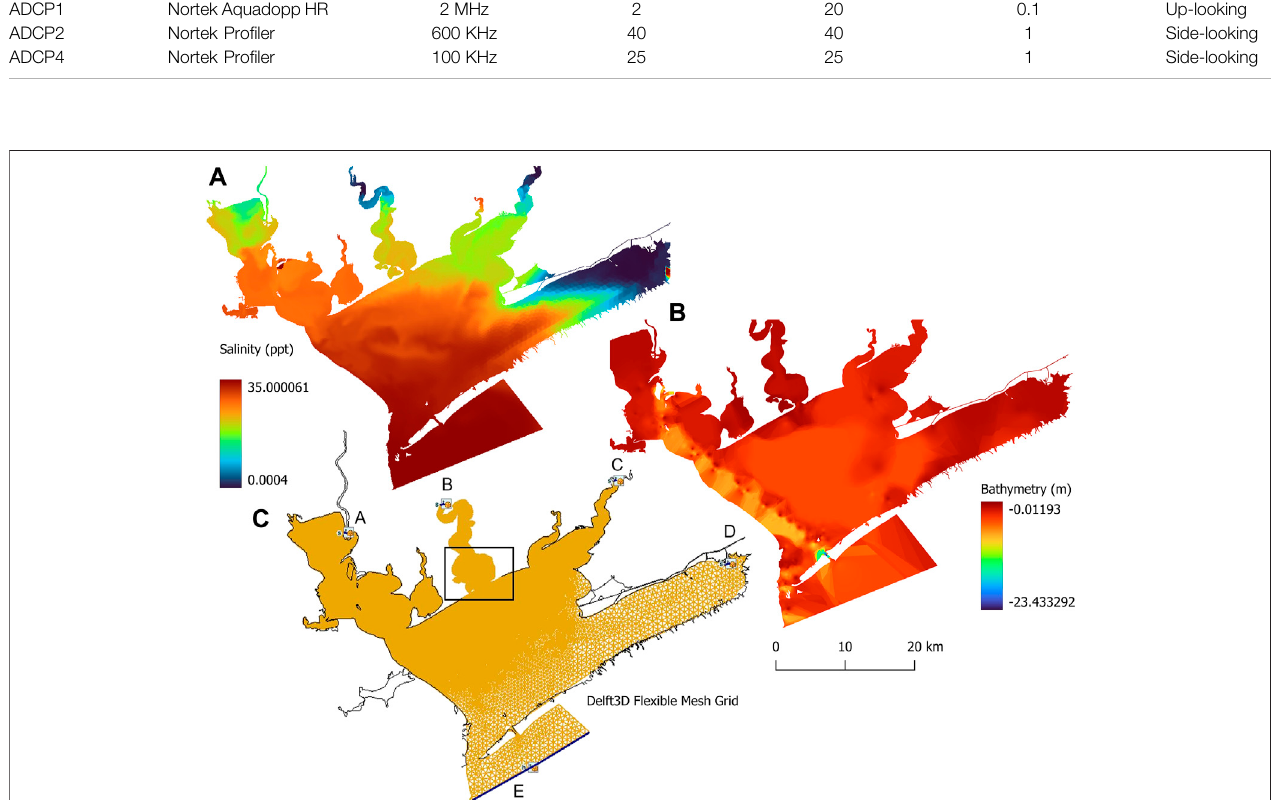
FIGURE 3 | (A) The initial salinity input map at the start date, and the integrated bathymetric map. Vertical units for bathymetry are meters (NAVD88). (B) Salinity units are in parts per thousand. Flow model mesh. (C) Input forcing locations are shown for: (A) Lavaca River input boundary, (B) Carancahua Creek input boundary, (C) Tres Palacios River input boundary, (D) Colorado River input boundary, and (E) Gulf of Mexico input boundary. The black box indicates the main area of interest were observation points and barriers were